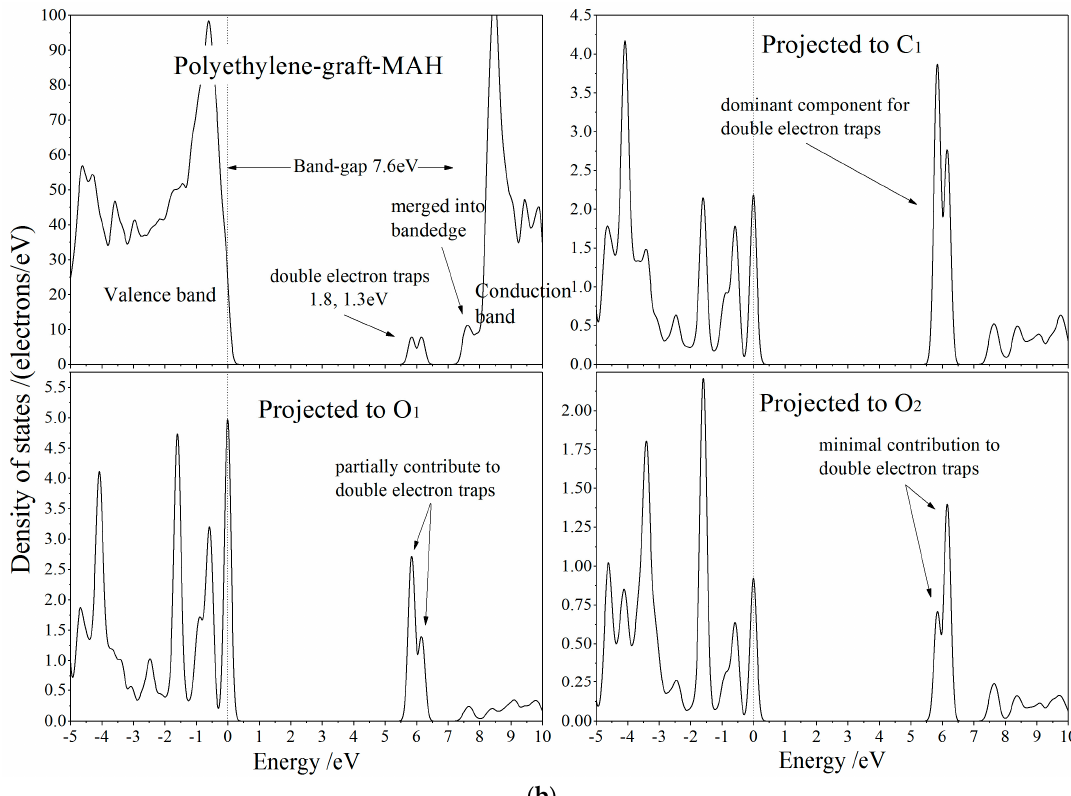
Figure 7. ( a ) Schematics of grafting MAH to polyethylene molecule with the carbon and oxygen atoms of carbonyl and the ester oxygen atom being identified by C 1 , O 1 , and O 2 , respectively and ( b ) the total and atomic-projected density of states for PE-g-MAH from first-principles calculations. The highest occupied molecular orbital (HOMO) level is set to be the energetic zero, as indicated by the vertical dashed line.